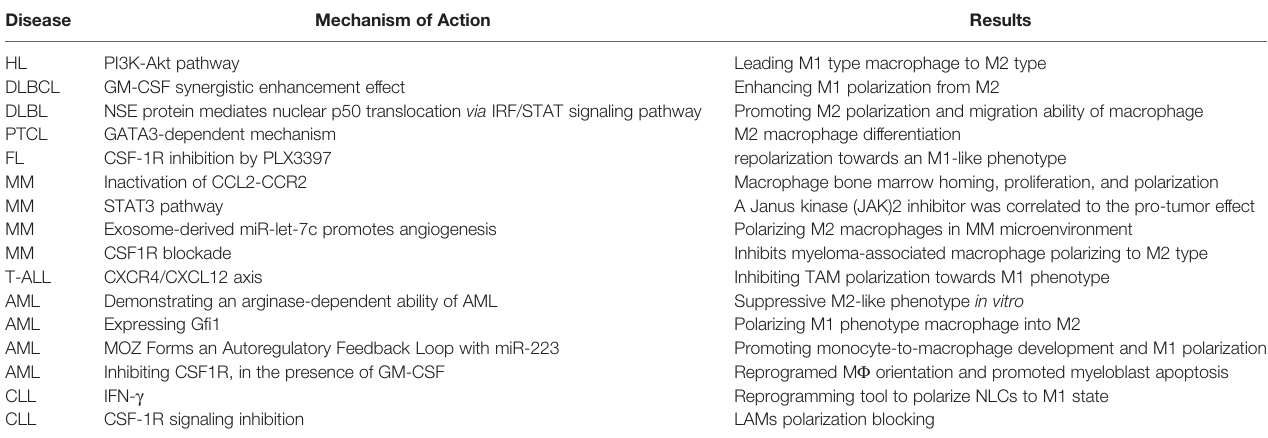
TABLE 1 | Pathways shifting macrophage polarization in hematological malignancies. Disease